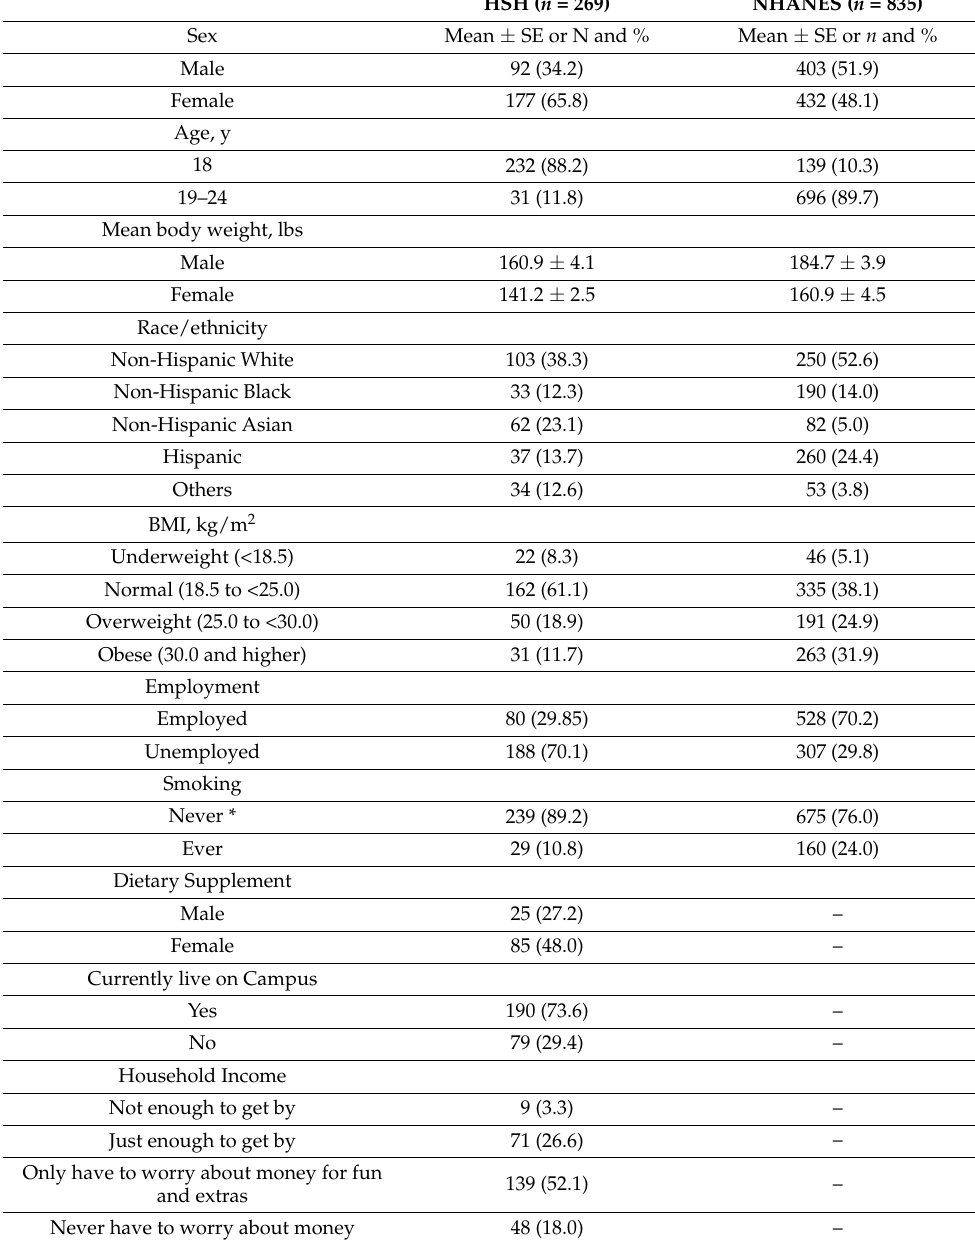
Table 1. Baseline characteristics of the Mason: HSH cohort and NHANES age-matched